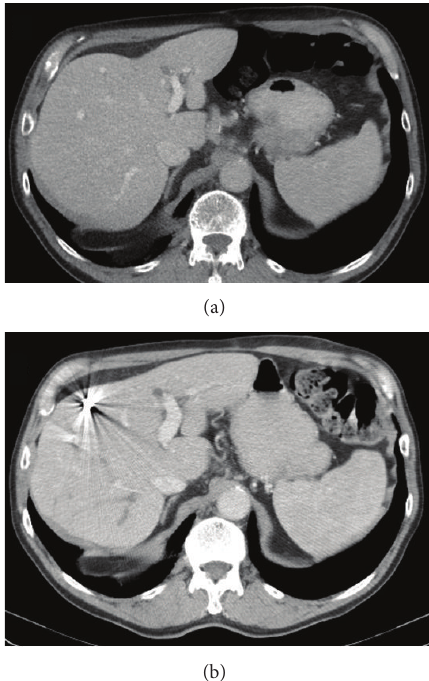
Figure 3: The liver in a patient with a large colorectal liver metastases on the right side before (a) and after (b) portal venous embolization.